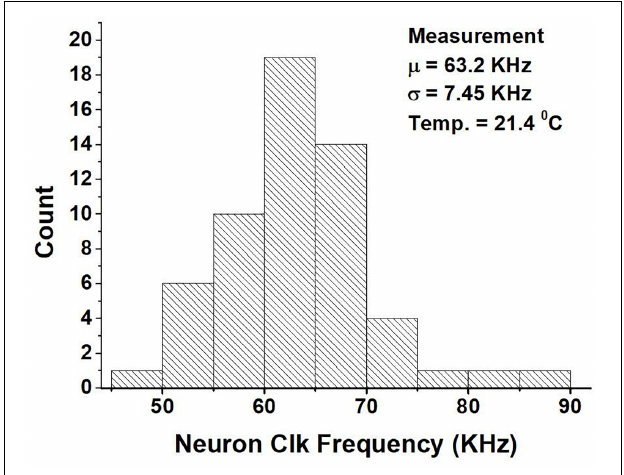
FIGURE 13 | Measurement of the neuron clock frequency of around 50 neurosynaptic cores across 10 chips at a supply of 0.52 V.